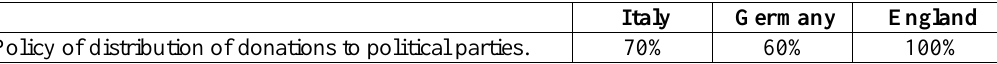
Table 10: Standard Behaviour in Relations with Political Organizations Policy of distribution of donations to political parties. 70% 60%